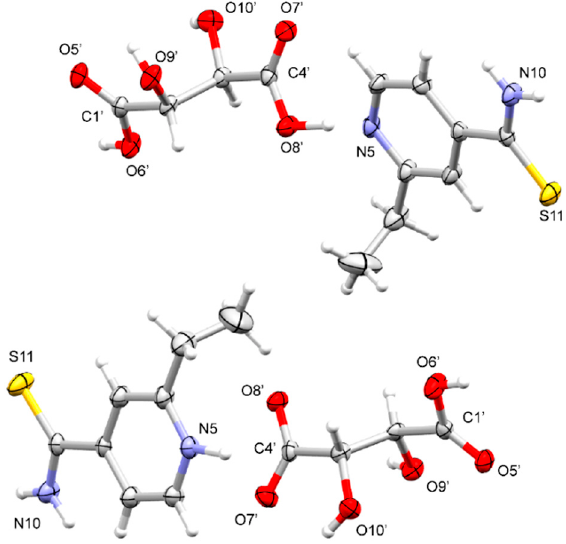
Figure 5. Asymmetric unit of ETN·TAR.